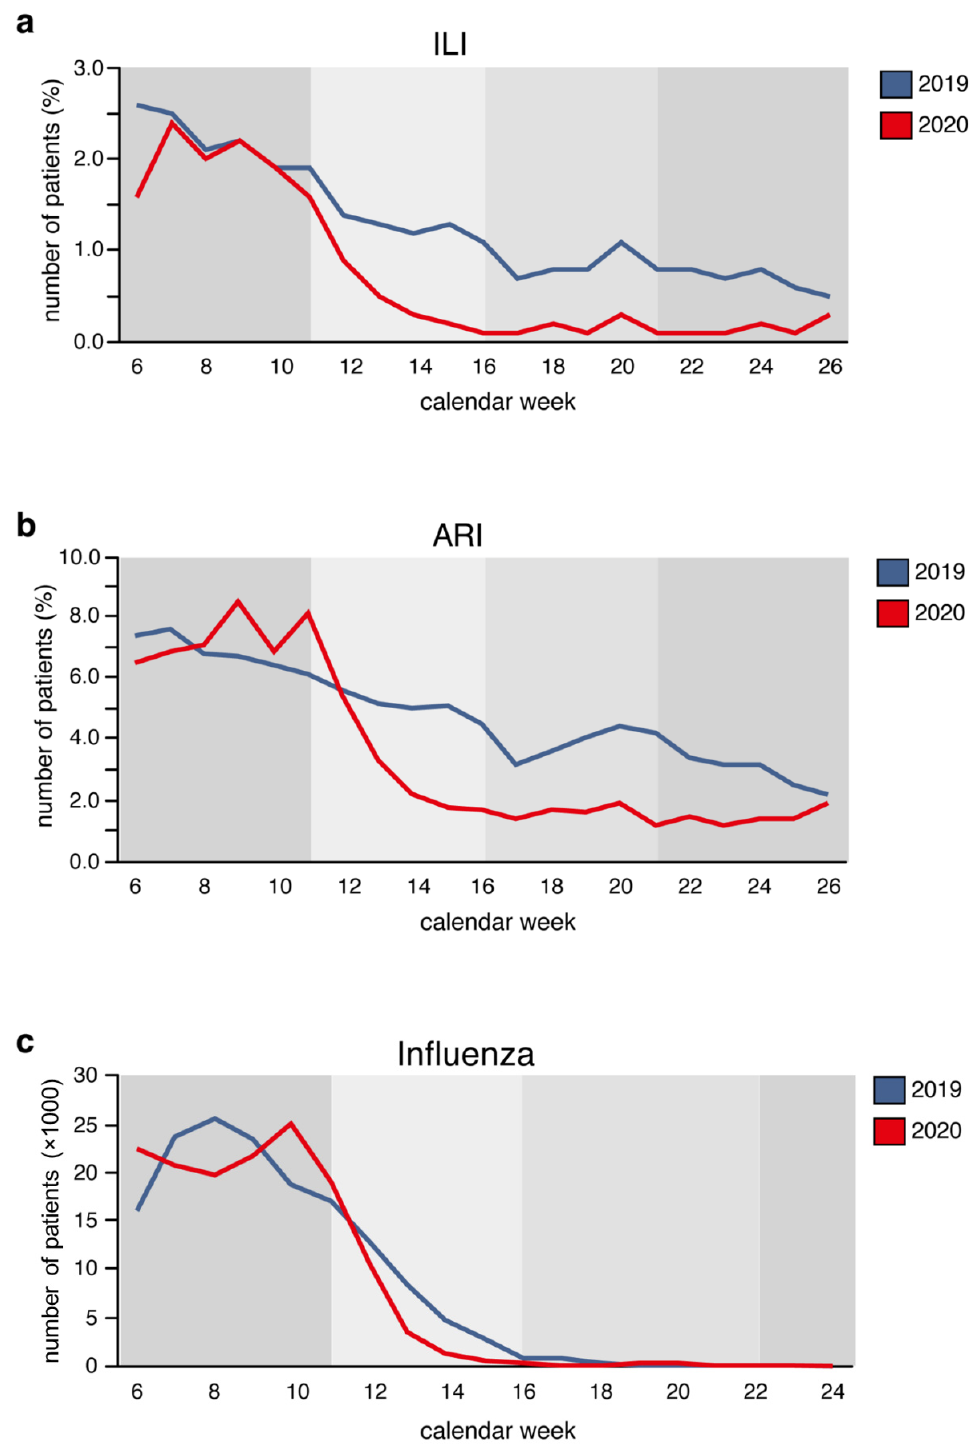
Figure 4. The rate of ( a ) influenza-like illness (ILI) and ( b ) acute respiratory illness (ARI) measured by GrippeWeb, excluding SARS-CoV-2 infections, as well as the number of ( c ) influenza reports submitted to the Robert Koch Institute within the weeks 6–26 in the years 2019 (blue) and 2020 (red). The public shutdown for the COVID-19 pandemic was announced for calendar weeks 12–16. The calendar weeks 6–11 were before, and the weeks 17–21 and 22–26 after, the public shutdown.